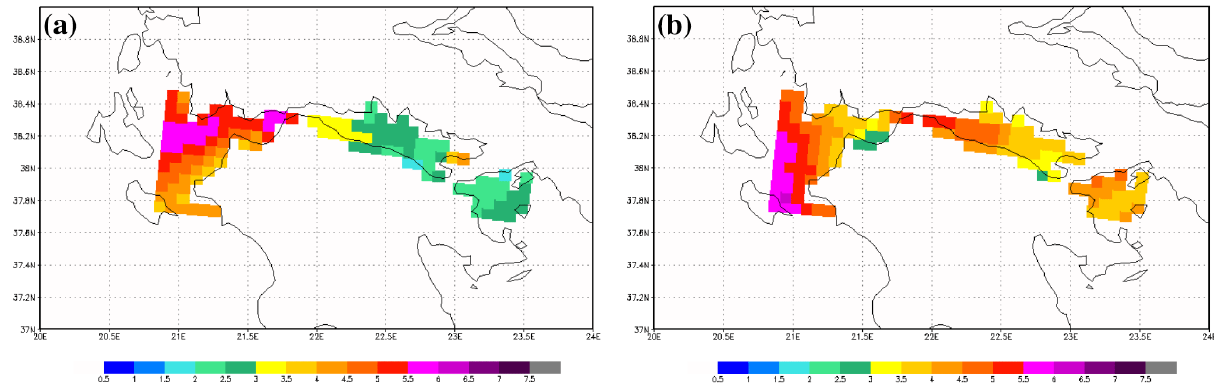
Fig. 6. Mean wind speed at 10m derived from 6h model data for ( a ) the eastern sector (wind direction from 45 to 135 ◦ ) and ( b ) the western sector (wind direction from 215 to 315 ◦ )